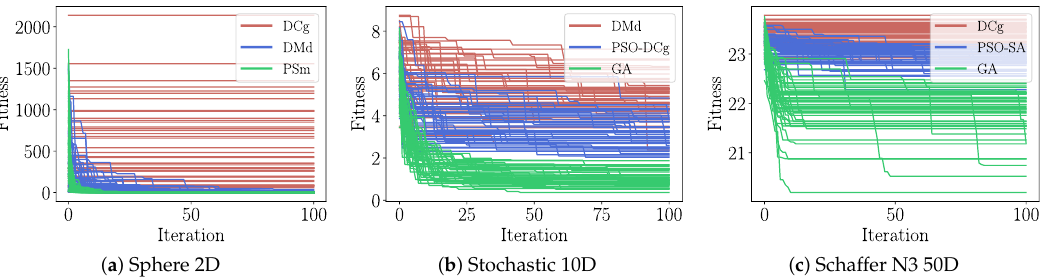
Figure 6. Fitness evolution for some selected metaheuristics solving the problems Sphere 2D, Stochastic 10D, and Schaffer N3 50D. Green, blue, and red strokes are used for the best, mid, and lowest ranked solvers,